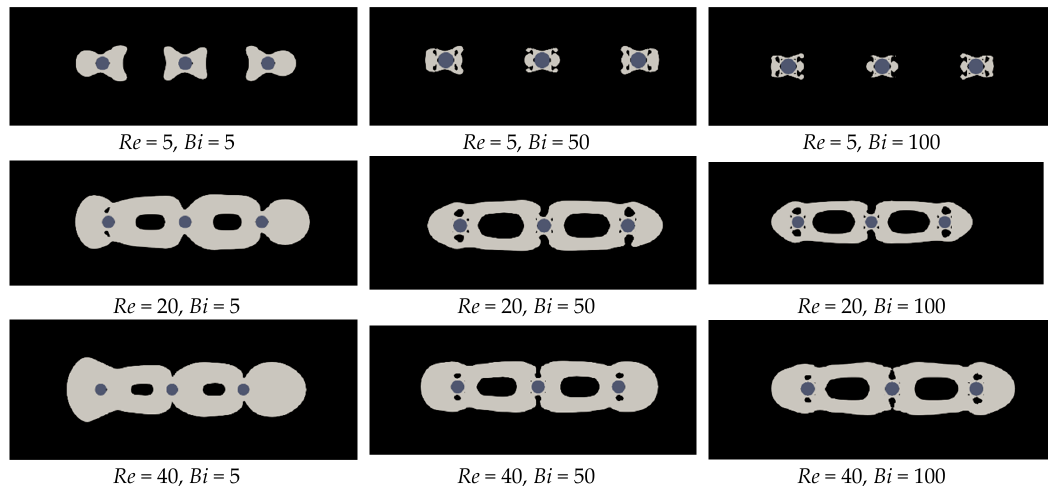
Figure 9. Progressive growth of the unyielded region (shaded) with the increasing Bingham number and decreasing Reynolds number where d = 4.0 D.